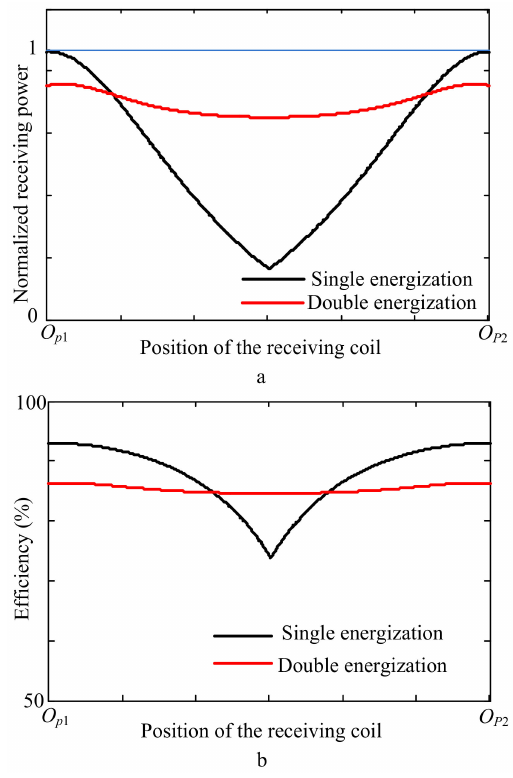
Figure 7. The comparative characteristics of different energizing modes varying with the position of the receiving coil. ( a ) The normalized receiving power. ( b ) The